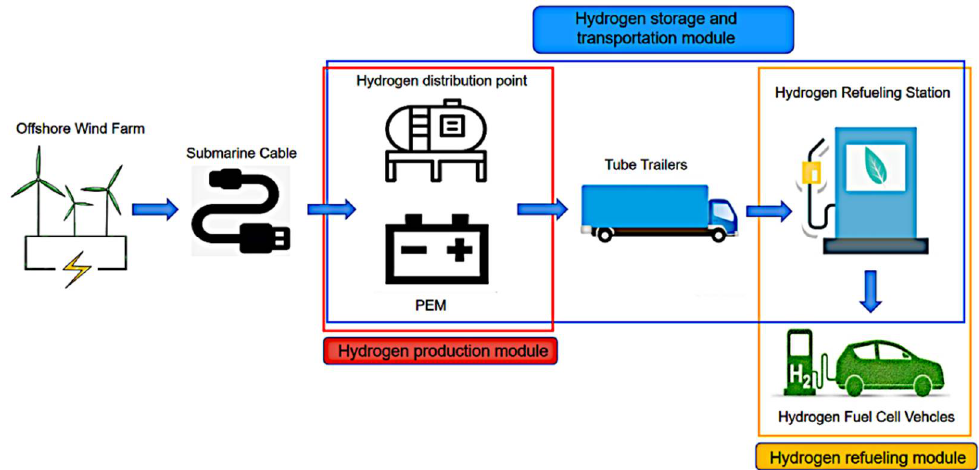
Figure 6. Technical route diagram.